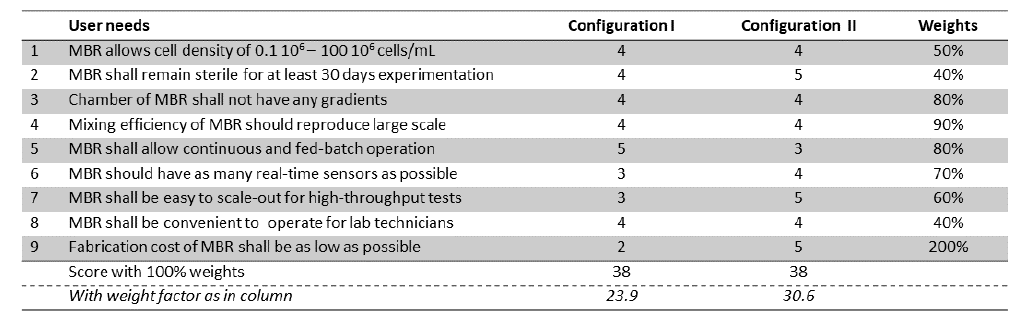
Figure 6. ( A ) Functional components for conceptual design of a MBR for bioprocess development; ( B ) Two configurations of these functional components; ( C ) Comparison and ranking of these two configurations versus user needs in Table 4 in which scores are calculated for weight factors all 100% or as in last column in the table.